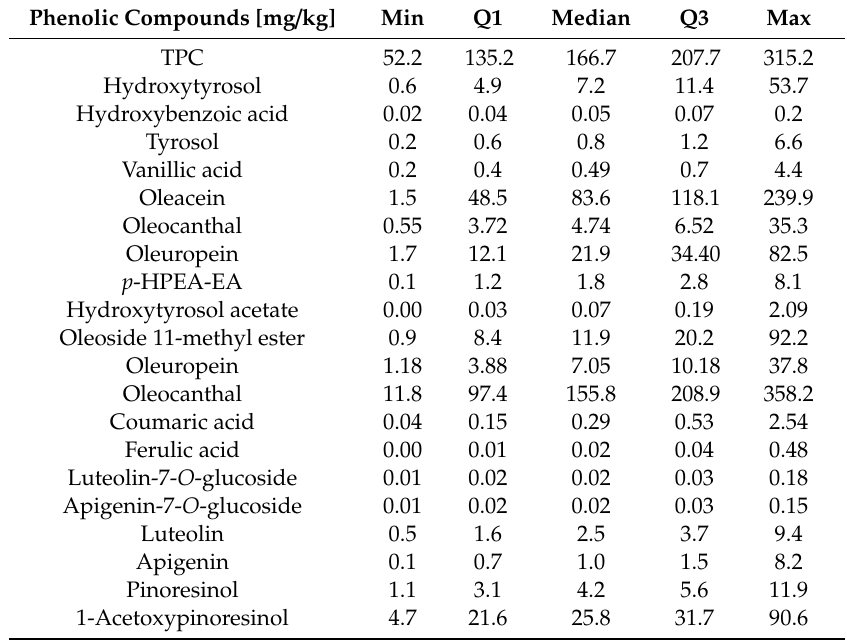
Table 1. Statistical distribution of all analyzed biochemical compounds found in olive oil. Data are presented as mean ± SD ( n =